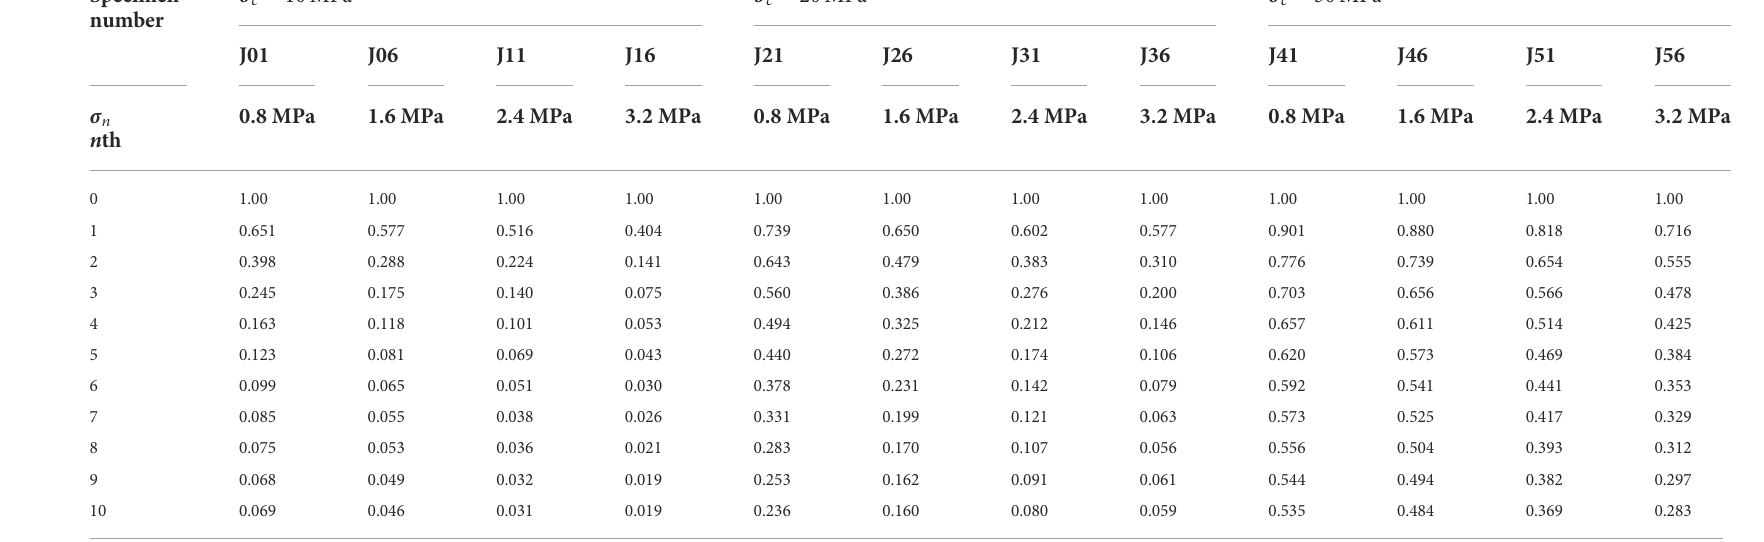
TABLE 1 Experimental results of R s of specimens with the initial undulant angle of 16 ° (Liu et al., 2013b). Specimen